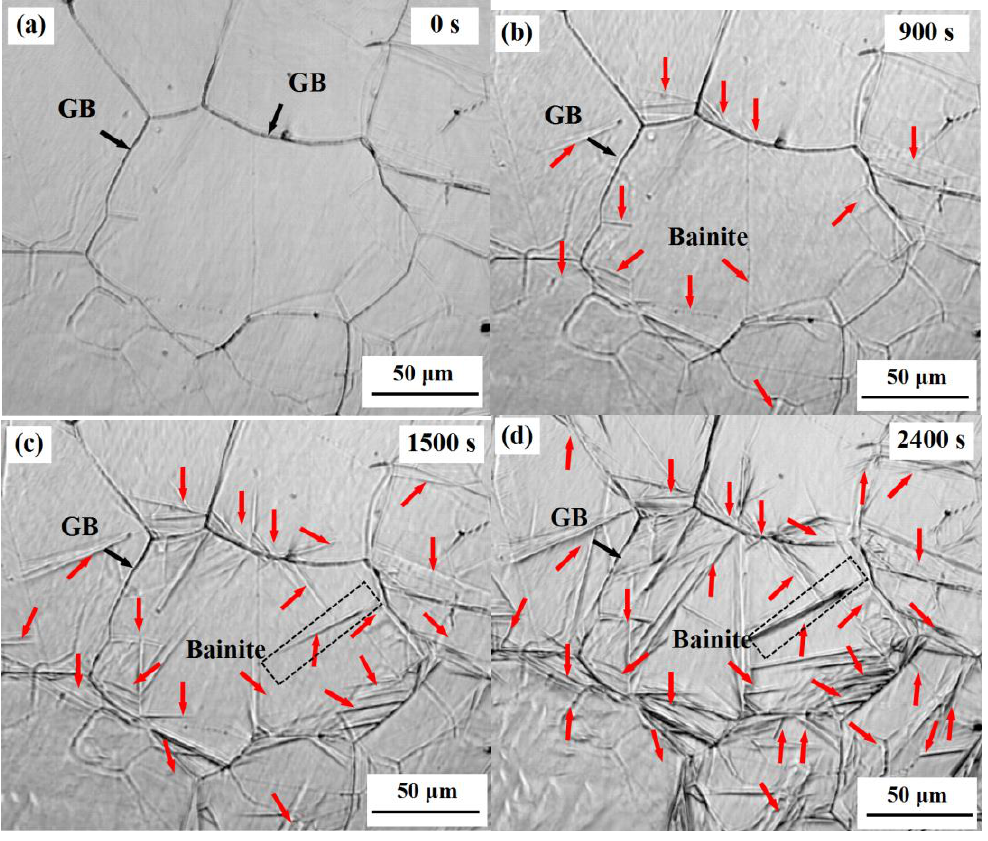
Figure 4. LSCM images of the DIT specimen, heating at 300 °C for several time lengths. ( a ) 0 s, ( b ) 900 s, ( c ) 1500 s, ( d ) 2400 s.